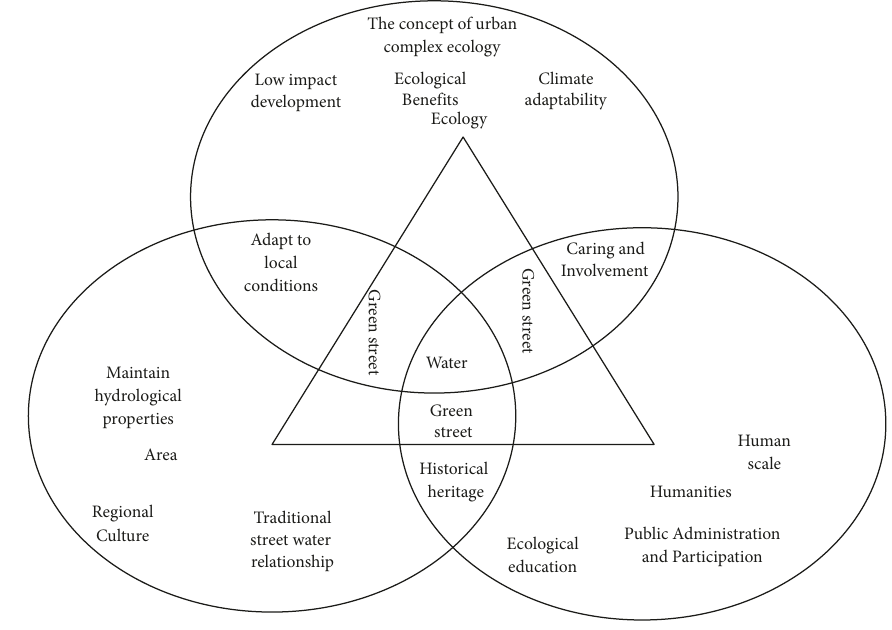
Figure 4: Functions of green streets.